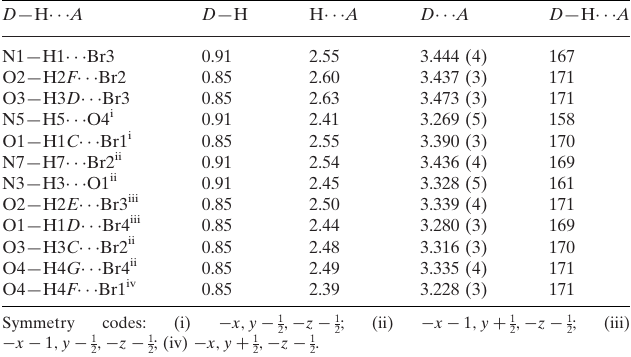
Hydrogen-bond geometry (A˚ , (cid:4) ). D —H (cid:2)(cid:2)(cid:2)